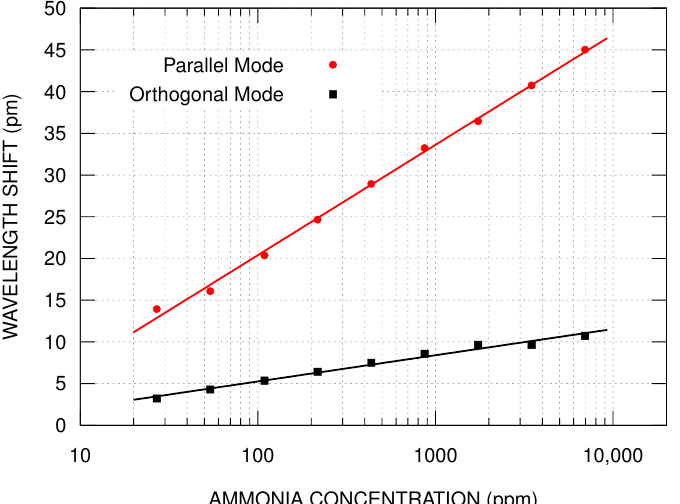
Figure 8. Simulation results of the sensor’s response for both modes in the same range as Figure 6 to ease the comparison. The ammonia concentration was mapped using the effective refraction index of the parallel